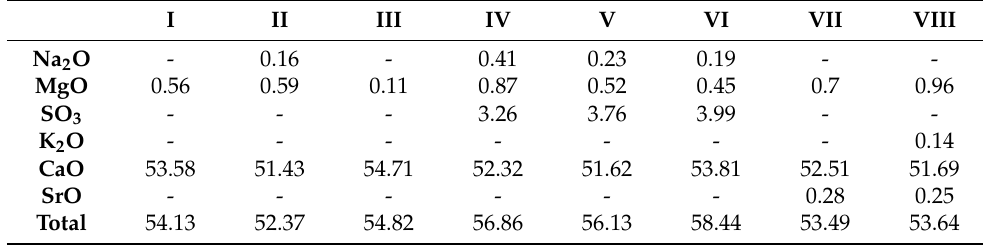
Figure 3. Evaluated XRD pattern of a characteristic sample. The dominant mineral phase is calcite (red columns), whereas aragonite is also present (blue columns). Table 1. Representative microanalyses of calcium carbonate mineral